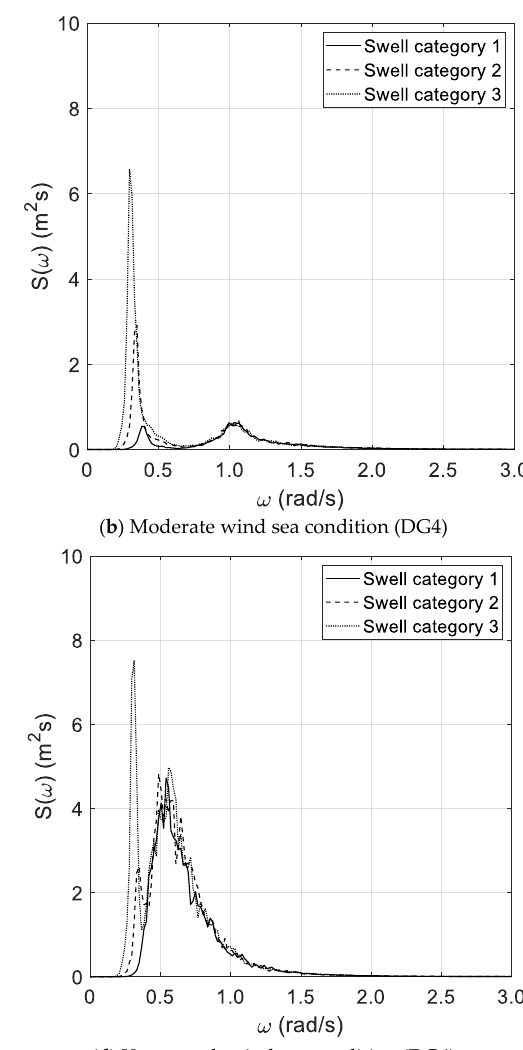
Figure 2. Spectral analysis (Thomson)—long duration.